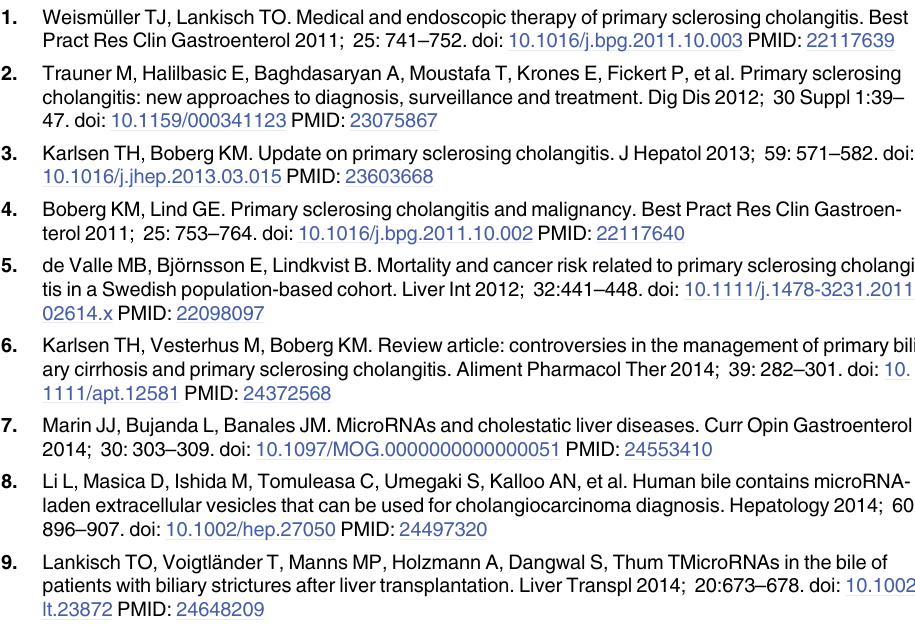
S3 Table. Demographics and laboratory parameters of the screening cohort (bile analysis). RNA pools of 15 patients with primary sclerosing cholangitis (PSC) and eight patients with cholangiocarcinoma (CC) identified several deregulated miRNAs in bile. The screening patients were matched for gender and age. Demographics and laboratory values of the screen- ing cohort are presented in S3 Table . Data were expressed as number or median with inter- quartile range (IQR). ALT: alanine aminotransferase; AST: aspartate aminotransferase; AP: alkaline phosphatase; GGT: gamma-glutamyl transferase; CRP: C-reactive protein; WBC: